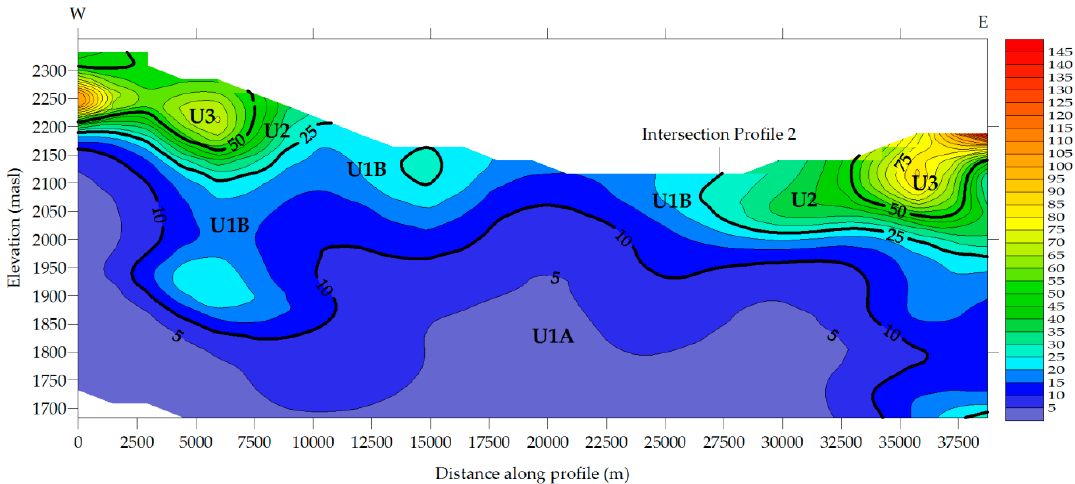
Figure 10. Two-dimensional time–domain electromagnetic models along West–East Section 1.